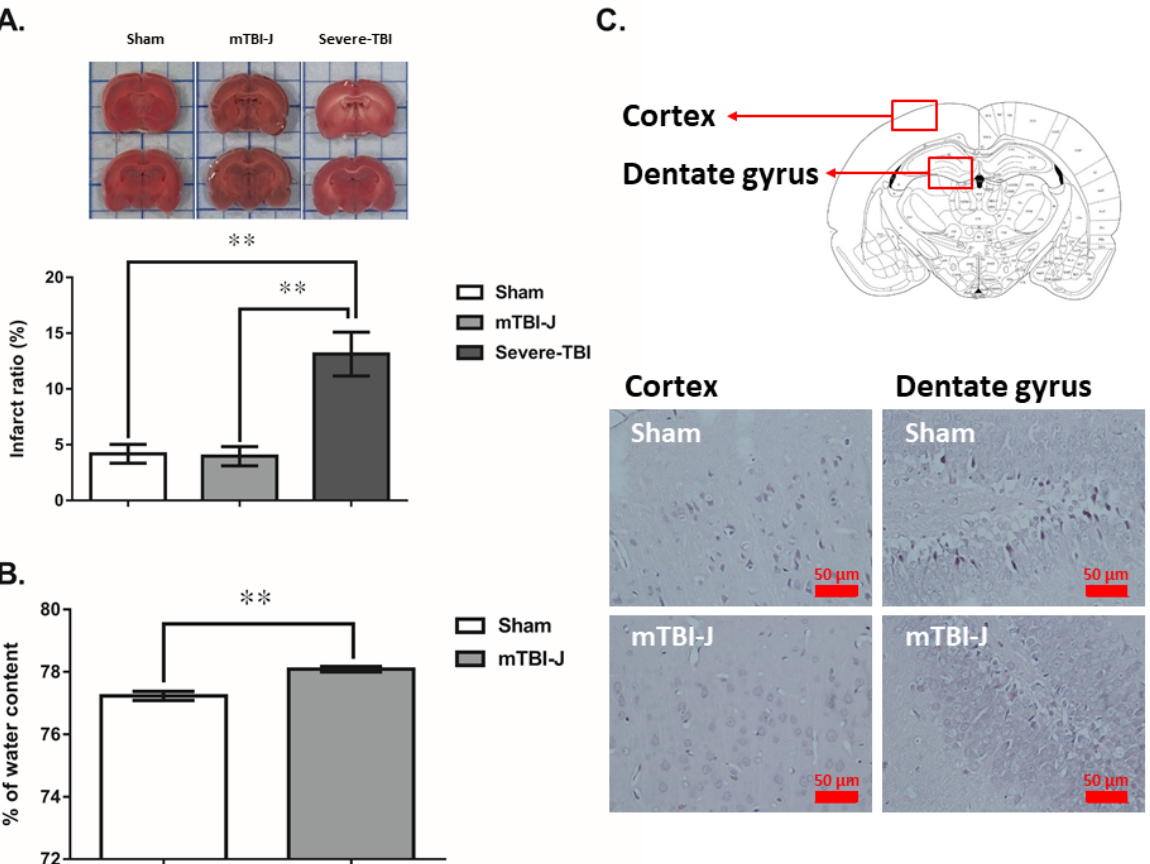
Figure 2. Evaluation of the mTBI-J induced cerebral damage and brain edema. ( A ) Animals are divided into sham, juvenile mild traumatic brain injury treated (mTBI-J), and severe traumatic brain injury. The percent of the total white area was a significant increase in the severe-TBI group, and no significant difference was between mTBI-J and sham control groups. ( B ) The significant difference in the edema between sham and after mild traumatic brain injury 24 h. ( C ) Results of the H&E stain did not reveal significant neural damage in the cerebral cortex and hippocampus. Values are shown as mean ± SEM, ** = p < 0.01 compared with the sham control group.